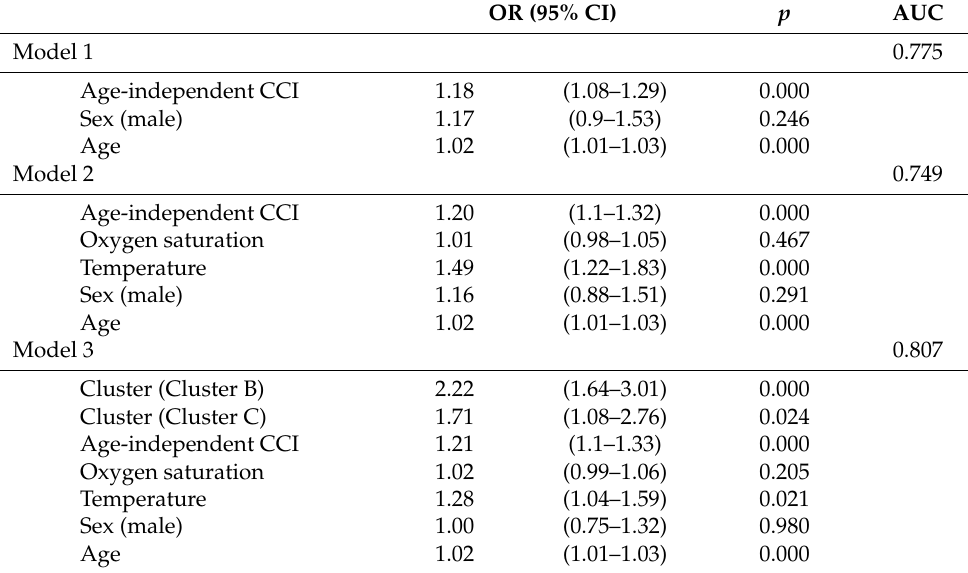
Table 4. Logistic regression model for the risk of mechanical ventilation.